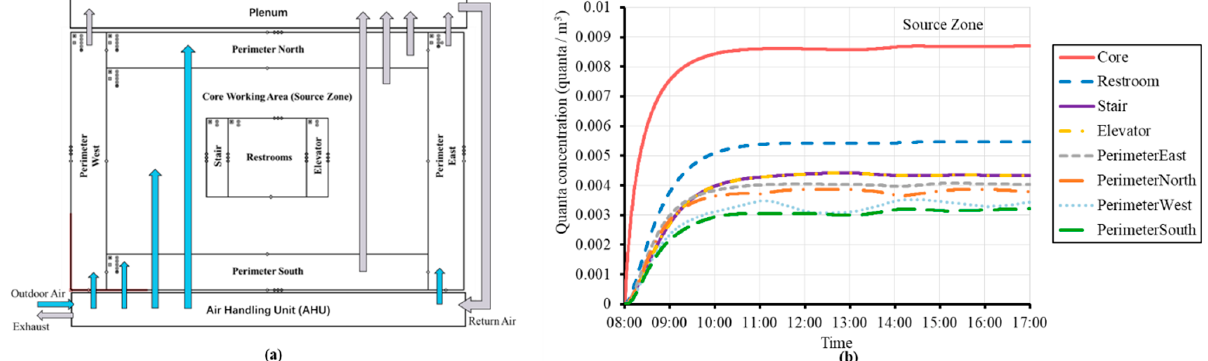
9 of 25 Figure 4. Seventy-two combinations of mitigations evaluated in this study. 3. Simulation Results